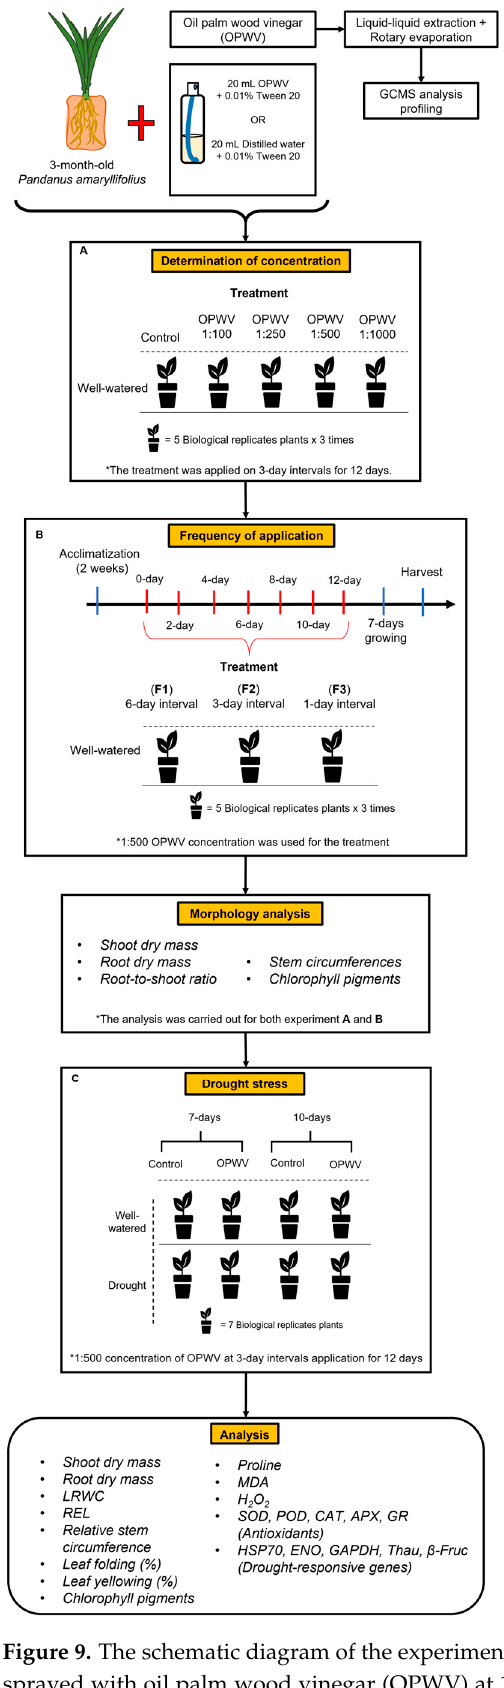
Figure 9. The schematic diagram of the experimental setup. ( A ) Pandanus amaryllifolius plants were sprayed with oil palm wood vinegar (OPWV) at 1:100, 1:250, 1:500, and 1:1000 dilutions in 3-day intervals until 12 days. The plants were allowed to grow for an additional 7 days before harvesting.